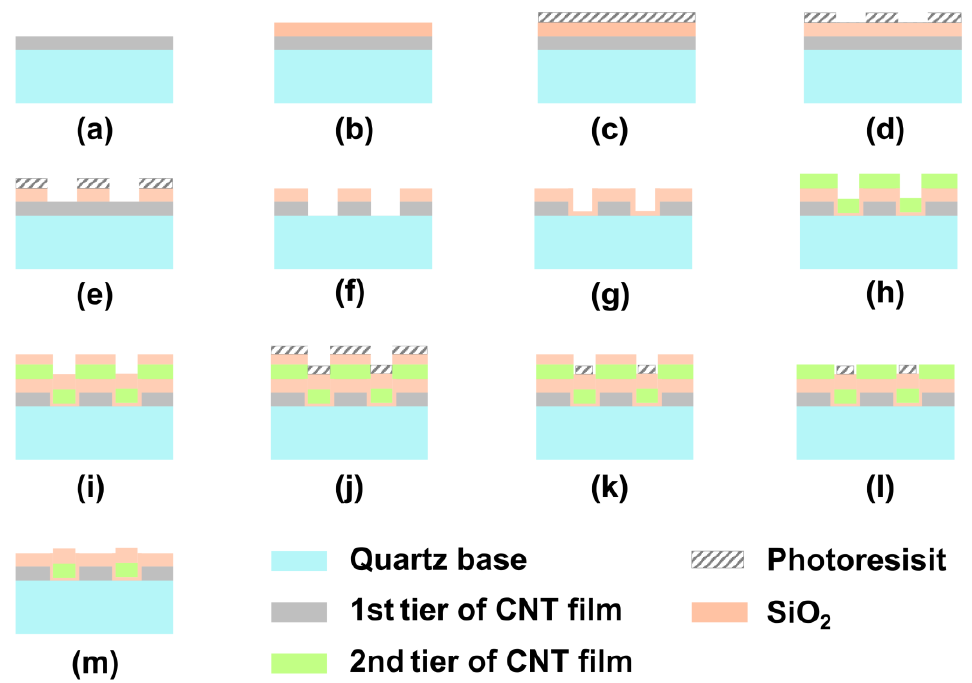
Figure 2. The fabrication process of a dual-tier micropolarizer array. ( a ) The first layer of CNT film is grown on the quartz substrate. ( b ) A layer of SiO 2 is grown on the CNT film as a hard mask. ( c , d ) Transferring the pattern through lithography and etching process to the photoresist. ( e ) Transferring the pattern to the hard mask via selective etching. ( f ) Transferring the pattern to the first layer of CNT film. ( g ) A layer of SiO 2 is grown as a protection layer. ( h , m ) The same steps of transferring the pattern to the 2nd tier of CNT film, referring to steps ( a , f ).